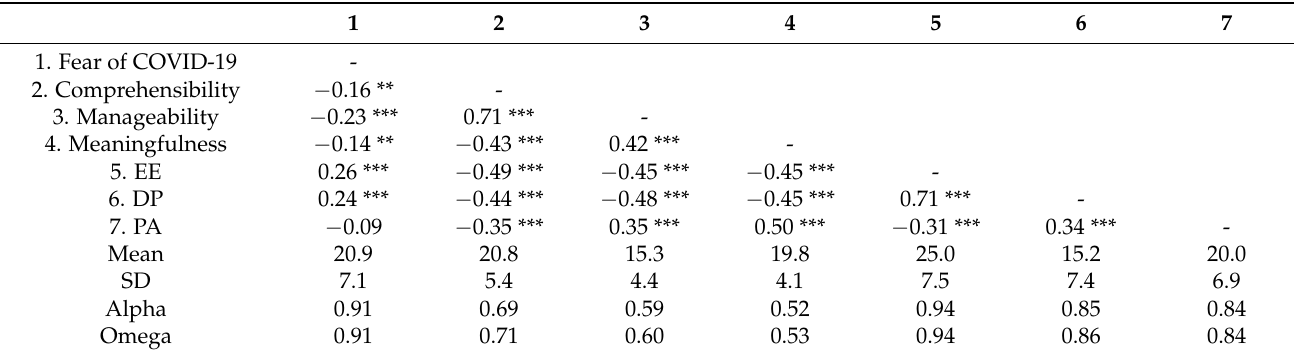
Table 1. Descriptive statistics, reliabilities, and intercorrelations between variables.